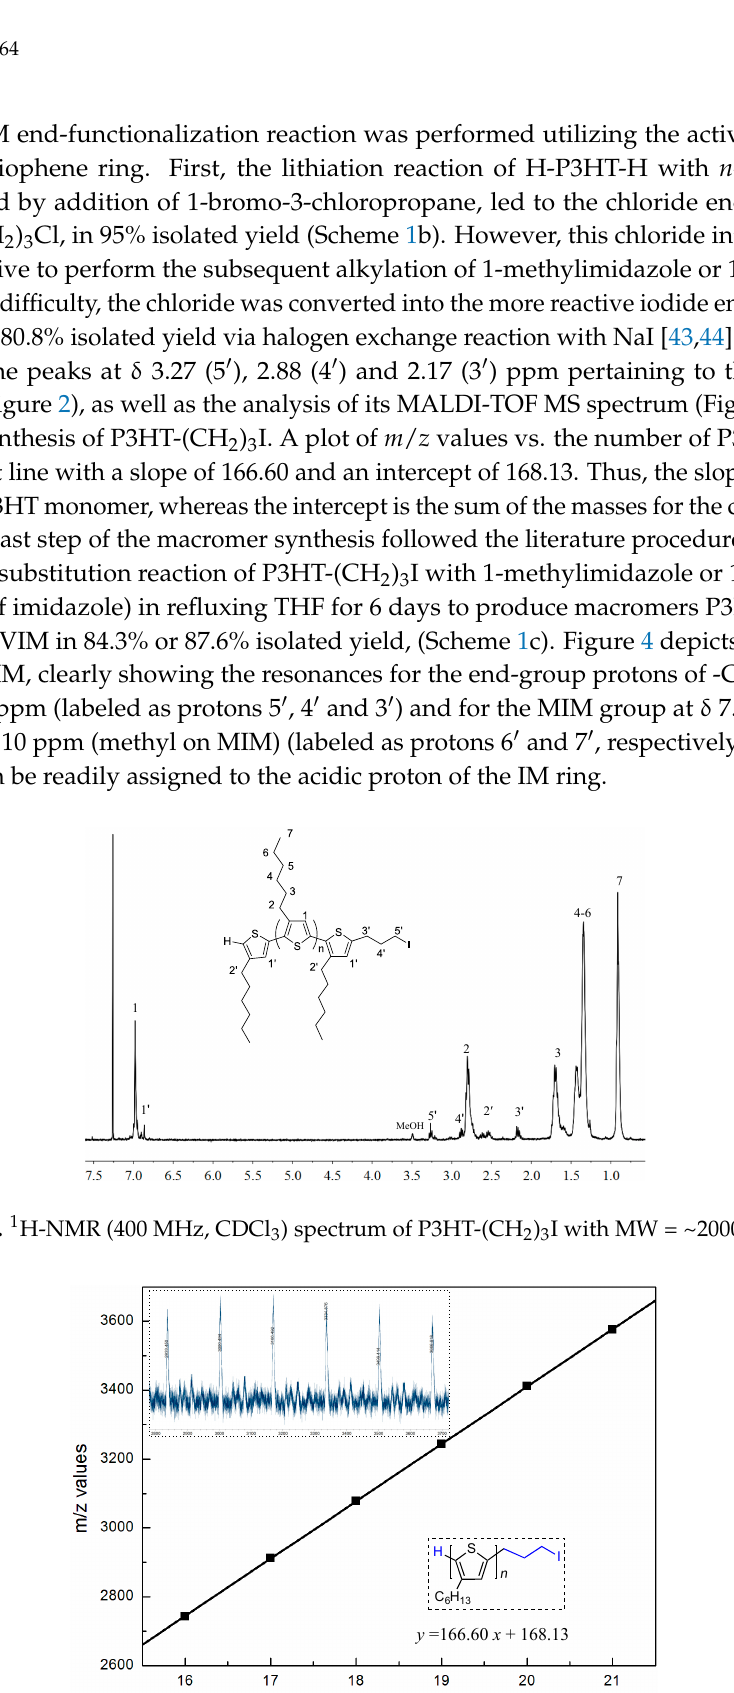
y =166.60 x + 168.13